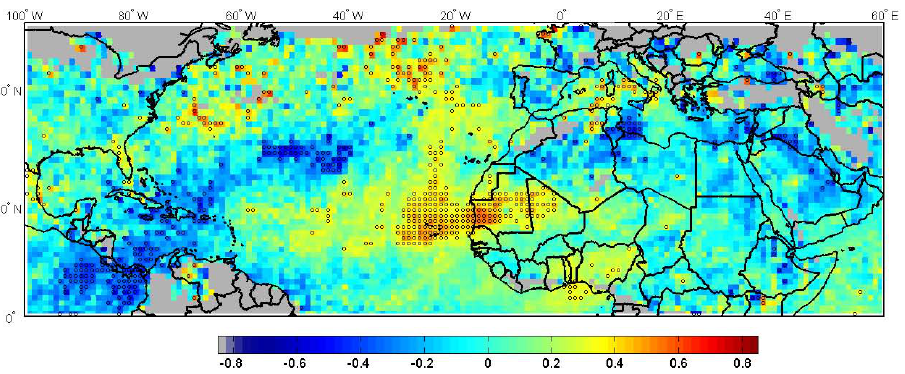
Fig. 6. Correlation of AOD anomaly and NAO Index during winter (DJF) months over the North Atlantic and surrounding regions (0–50 ◦ N, 100 ◦ W–60 ◦ E). Dots indicate significance at 95% confidence level. Regions shaded in grey indicate insufficient aerosol sample sizes. Table 1. Global and regional annual trends derived based upon 13-yr SeaWiFS AOD products (January 1998–December 2010). The cor- responding uncertainties are the 68% confidence limit. The derived trends in the regions with | ω / σ ω | > 2 are considered to be statistically significant at 95% confidence level. Latitude Longitude Slope